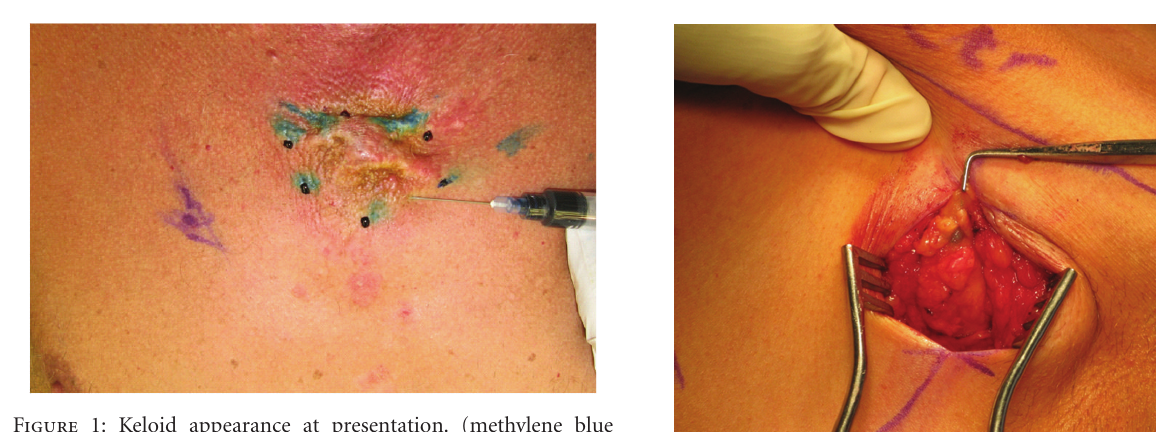
Figure 1: Keloid appearance at presentation. (methylene blue injection for sentinel lymph node biopsy).